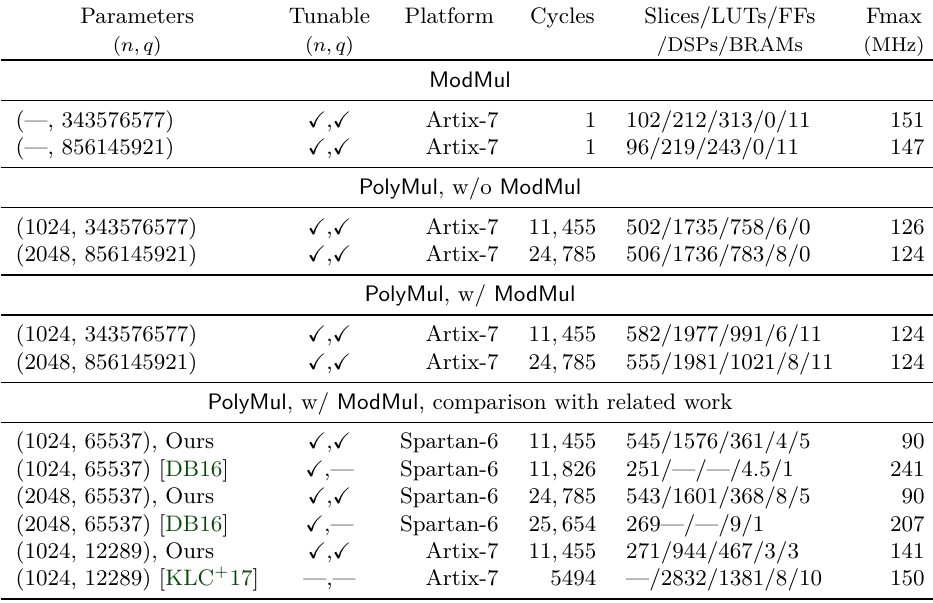
Table 5: Performance of the hardware modules ModMul and PolyMul (with and without ModMul included) and comparison with related state-of-the-art